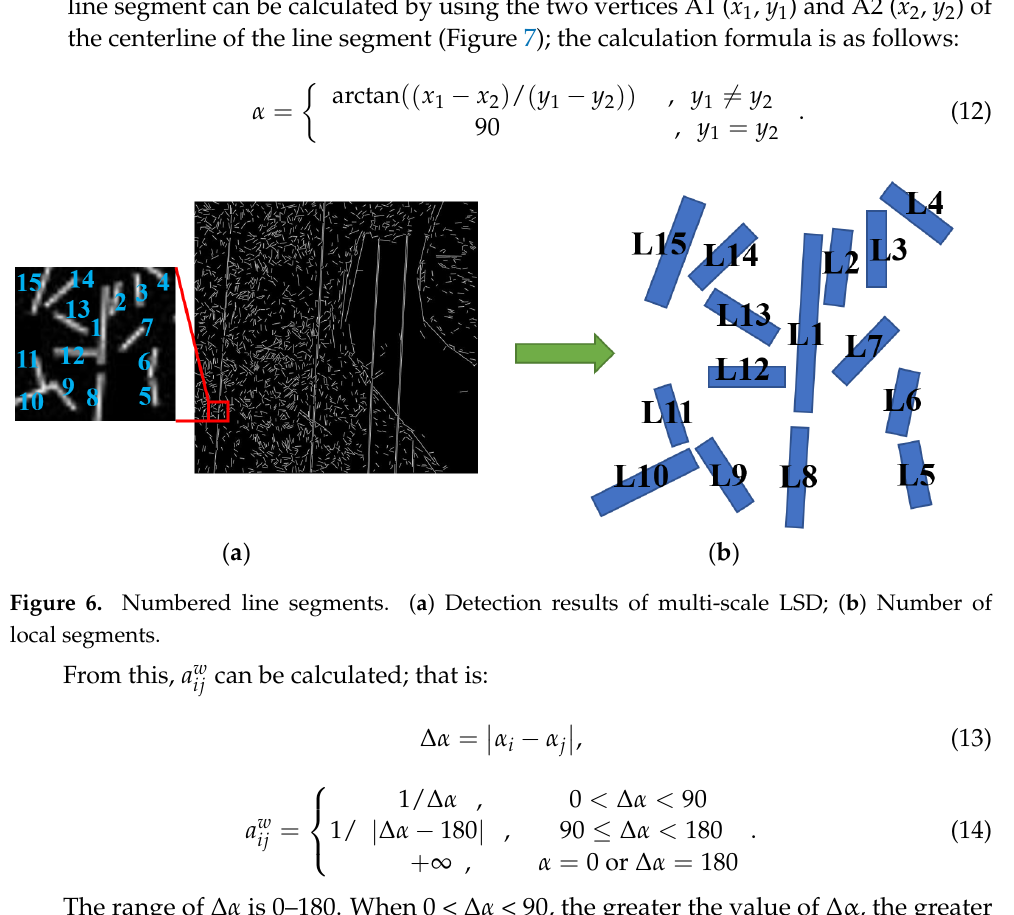
Figure 7. Neighborhoods of line segments.